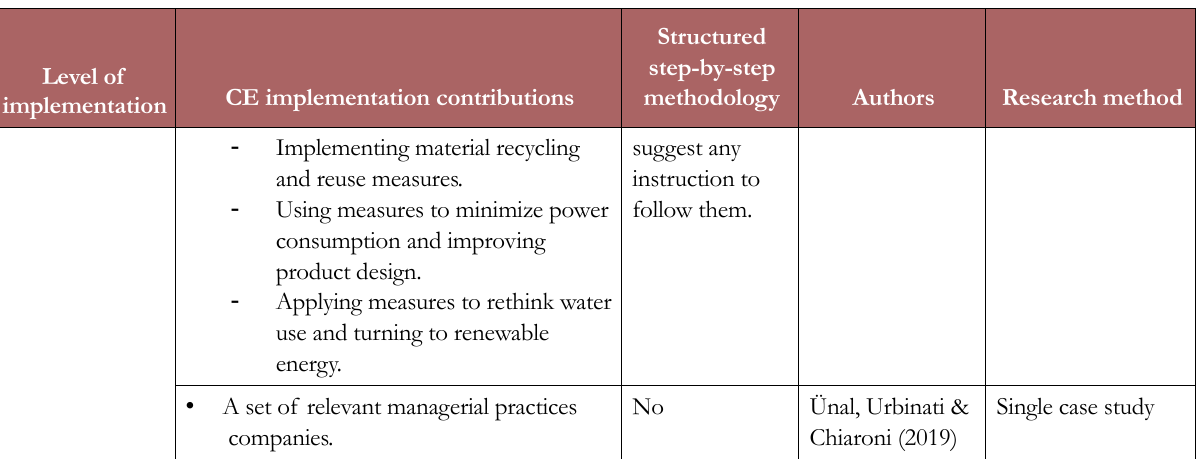
Table 1. Summary of pathways analyzed in the literature for the CE implementation in